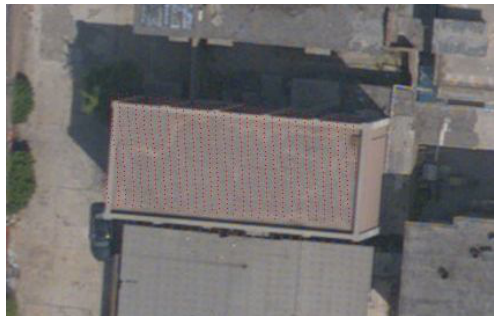
Figure 10. roof LiDAR points projected result